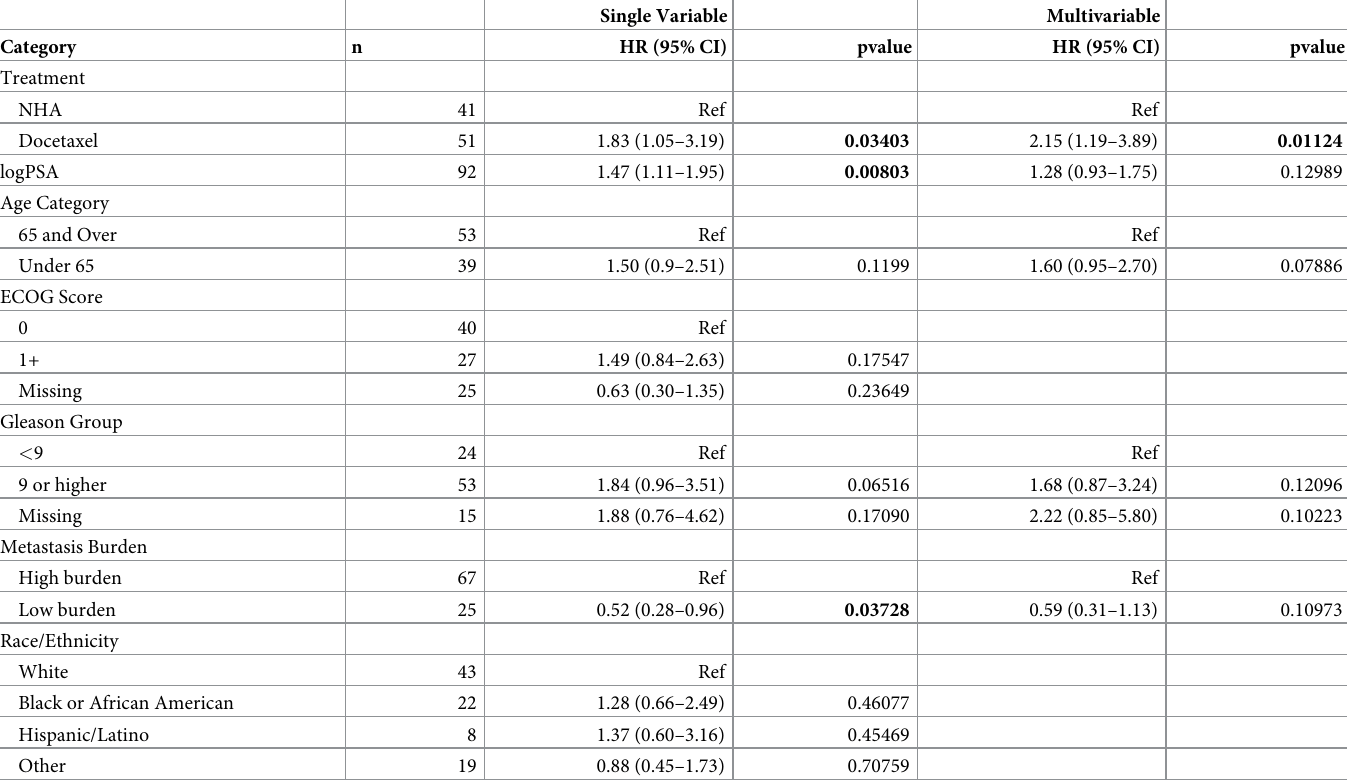
Table 2. Univariable and multivariable analysis of TTNT comparing upfront docetaxel to upfront NHA and the other co-variants. Single